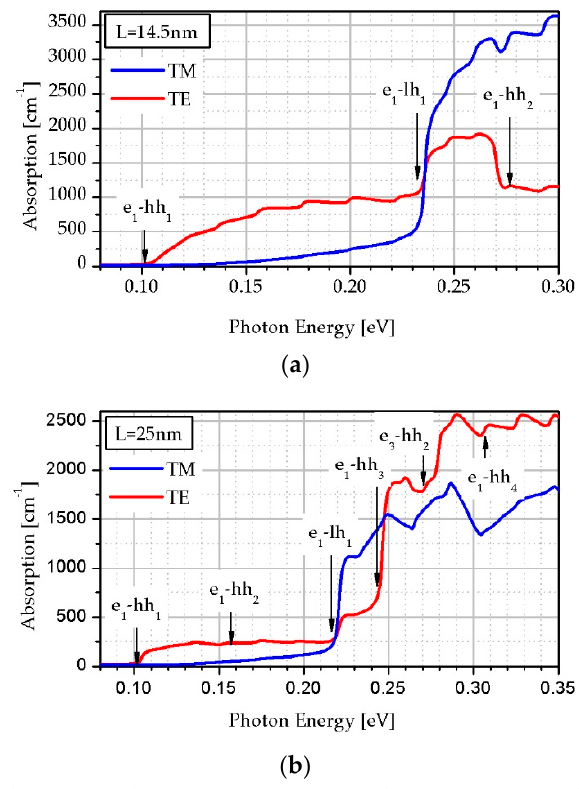
Figure 7. The polarization-dependent transverse electronic (TE) and transverse magnetic (TM) α versus energy in InAs/InAs 0.62 Sb 0.32 SL structures at 230 K for the SL period equal to: ( a ) 14.5 nm, ( b ) 25 nm.